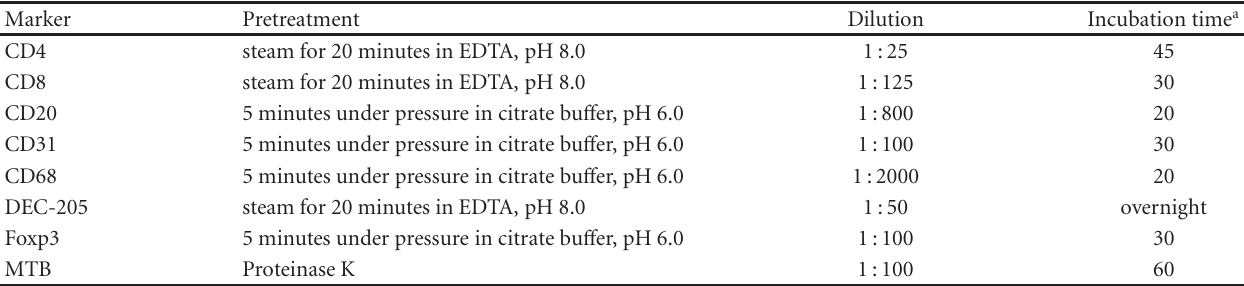
Table 1: Conditions for immunohistochemistry staining of immune cell markers and MTB.